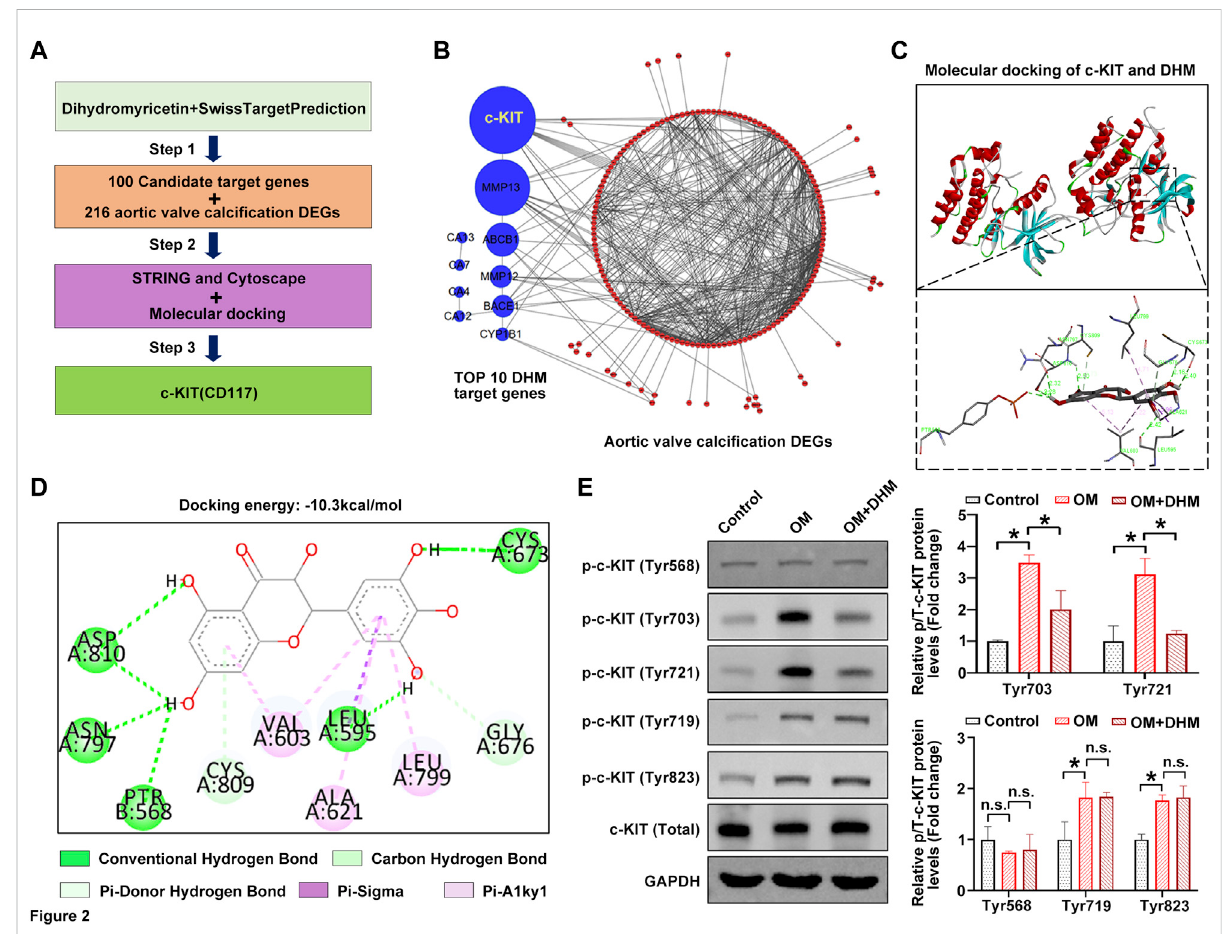
Dihydromyricetin (DHM) targets c-KIT involved in the regulation of aortic valve calci fi cation (AVC). (A) Flowchart of the identi fi cation of AVC- associated target genes regulated by DHM. (B) Protein – protein interaction (PPI) network of the top 10 candidate targets of DHM and 216 AVC differentially expressed genes (DEGs). (C) Molecular docking of DHM and c-KIT. (D) Two-dimensional (2D) diagram of the binding position between DHMandc-KIT. (E) Westernblottingwasusedtodetectthephosphorylationlevelsofc-KITinhumanvalvularinterstitialcells(hVICs)stimulated with osteogenic induction medium (OM) and then treated with or without DHM. One-way ANOVA followed by Bonferroni post hoc test . N = 3 per group. Values are the mean ± SD. * p < 0.05 indicates a signi fi cant difference. The n. s. indicates no signi fi cant